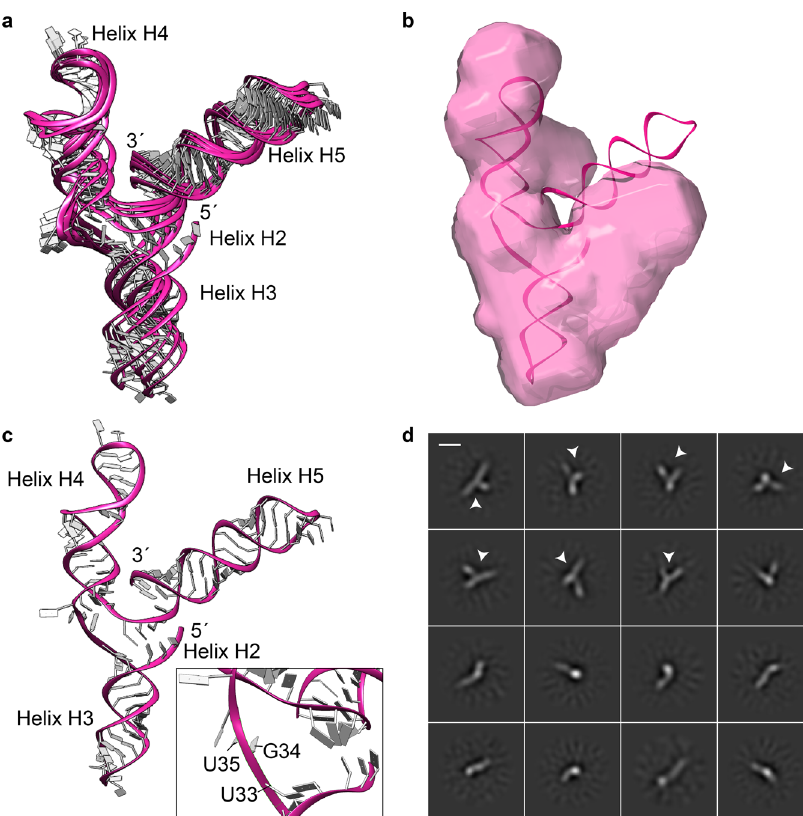
Fig. 5 Structure analyses of the Pf Alu118 RNA. a NMR-SAXS-based atomic models of Pf Alu118 RNA. b Ab inito model of Pf Alu118 RNA superimposed with the top scored Pf Alu118 RNA NMR-SAXS model calculated by SREFLEX. c Top scored Pf Alu118 RNA NMR-SAXS model with inset showing the UGU motif exposed at the three-helix junction. d Single-particle cryo-EM analysis of Pf Alu118 RNA shown with representative reference-free 2D-class averages. Arrows mark class averages where the Y-shaped architecture of the RNA is visible. Scale bar represents 30